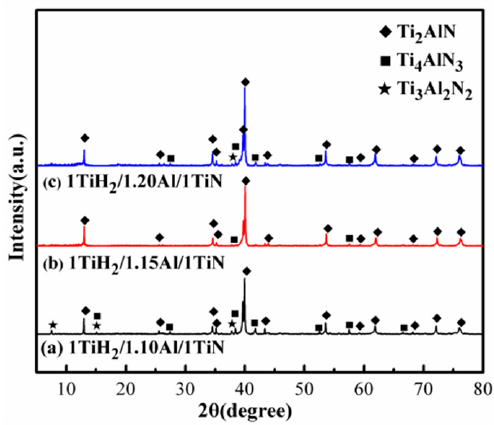
Figure 3. XRD patterns of the 1TiH 2 / (1 + x)Al / 1TiN powder mixture prepared by microwave sintering for 30 min at 1250 °C: ( a ) x = 0.1; ( b ) x = 0.15; and ( c ) x = 0.2.